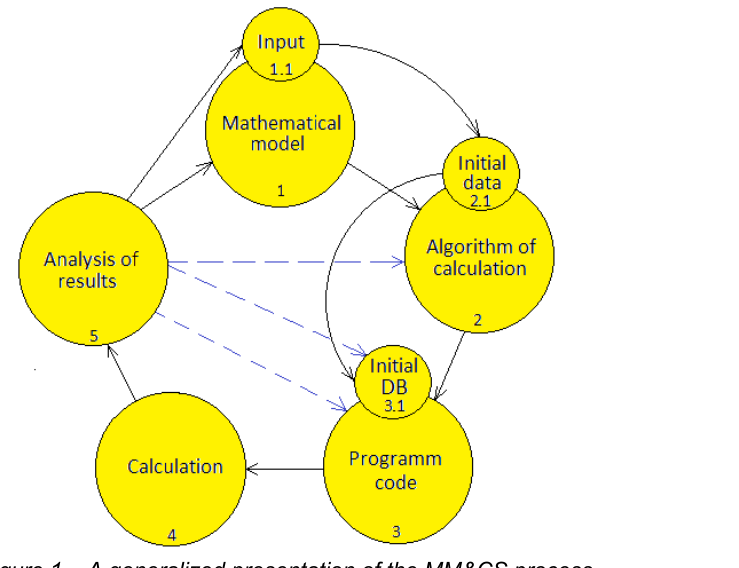
Figure 1 – A generalized presentation of the MM&CS process Рис . 1 – Обобщенное представление процесса